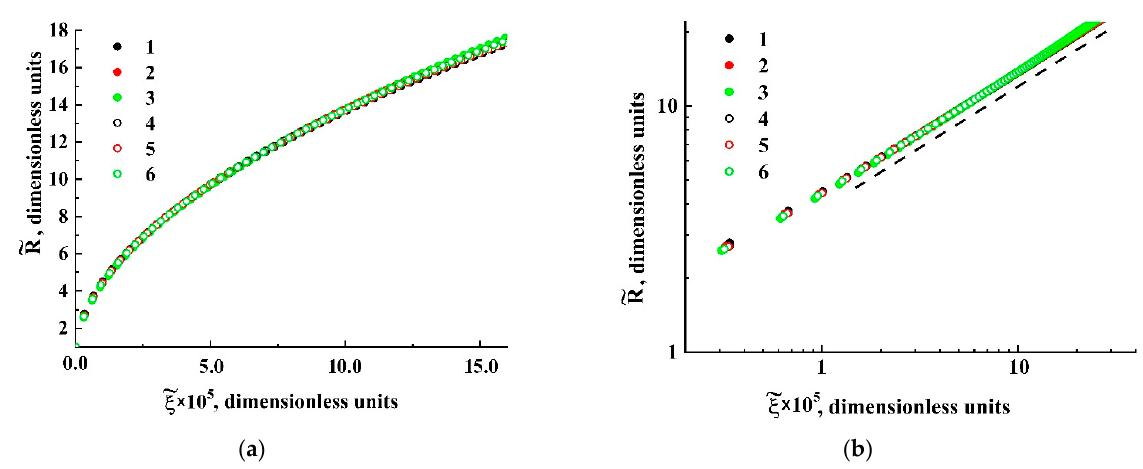
{ } (cid:110) (cid:111) { } R ψ ξ =  in the R ψ τ=  to the dependence in the linear (cid:101) ξ { } R ψ ξ = 